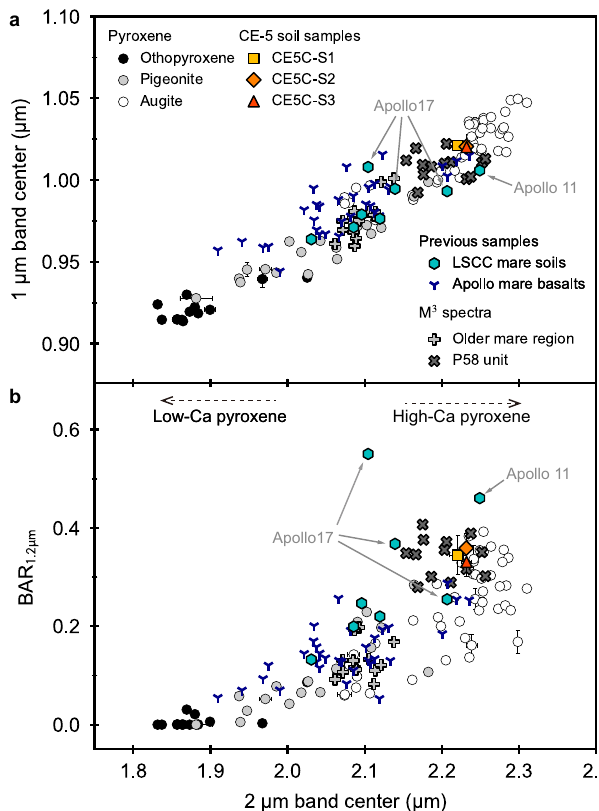
Fig. 3 | Spectral parameters comparison of the CE-5 samples with pure pyrox- enes, previous mare soil and basalt samples, and Moon Mineralogy Mapper (M 3 ) orbital spectra. a 1 μ m and 2 μ m band centers. b 1.2 μ m band area ratio (BAR 1.2 μ m ) and 2 μ m band center. How to derive these spectral parameters (1 μ m and 2 μ m band centers, BAR 1.2 μ m ) can be found in the Methods section. The selection of these pure pyroxenes isdescribed in Supplementary Note 1. The error bars of some pure pyroxene points indicate the standard deviation of the samples with different grain sizes, and the points without error bars are derived from a singlemeasurement.TheerrorbarsofCE-5soilsamplesarethestandarddeviation ofthederivedspectralparameters.ThespectralparametersofM 3 datacorrespond to the spectra shown in Fig. 6. Note that the spectral parameters of Lunar Soil Characterization Consortium (LSCC) 71061 sample are not shown in the fi gure, because itshowsuncommonspectralcharacteristicsdue tothehighabundanceof volcanic glass. Solid gray arrows indicate the LSCC samples from Apollo 11 and Apollo 17. Dashed arrows represent direction of dominant pyroxene